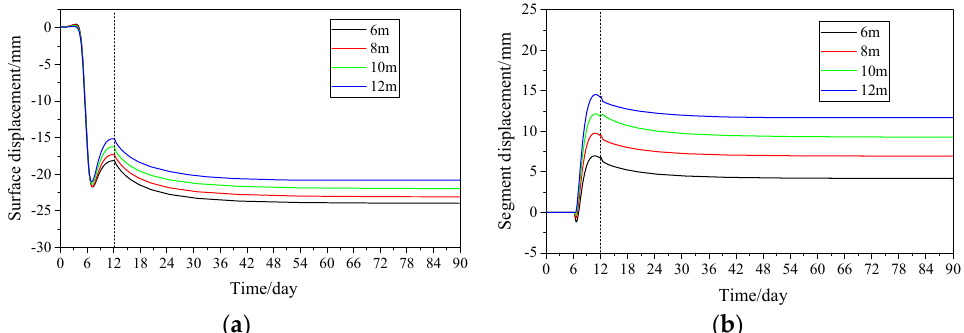
Figure 11. Displacement of surface and tunnel under the different thickness of the soft underlying layer. ( a ) Development of surface displacement with time; ( b ) Development of segment displacement with time.